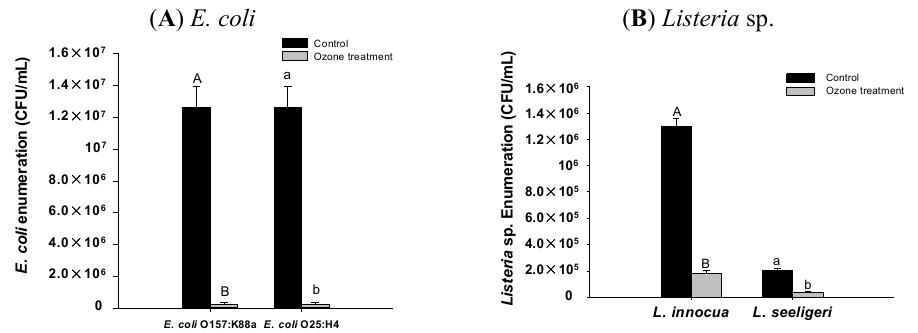
Figure 6. Impacts of increased levels of ozone exposure on two strains of ( A ) E. coli and ( B ) Listeria sp. inoculated onto the surface of spinach leaves. Leaves were either treated with 10 ppm ozone concentration (grey bar) or untreated (black bar) for 2 min. Values represent means (±Standard Error) of measurements made on three independent spinach leaves per treatment. Bars with different letters are significantly different ( p <